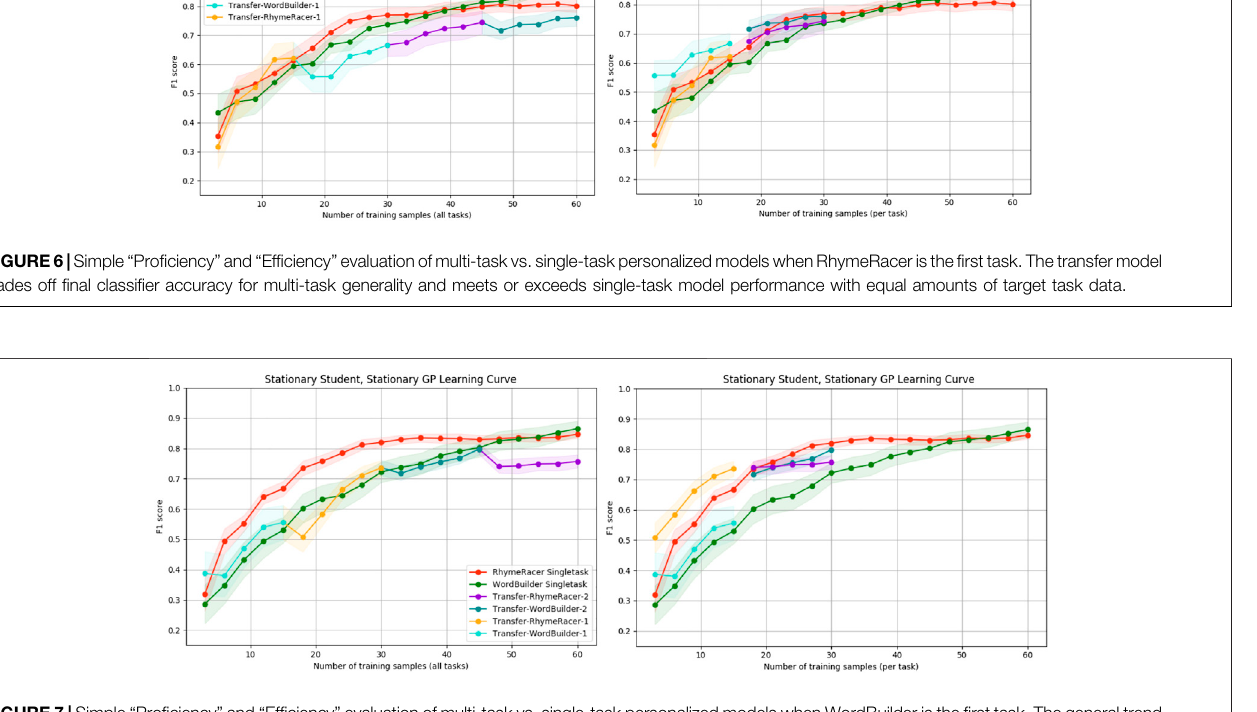
Frontiers in Robotics and AI |